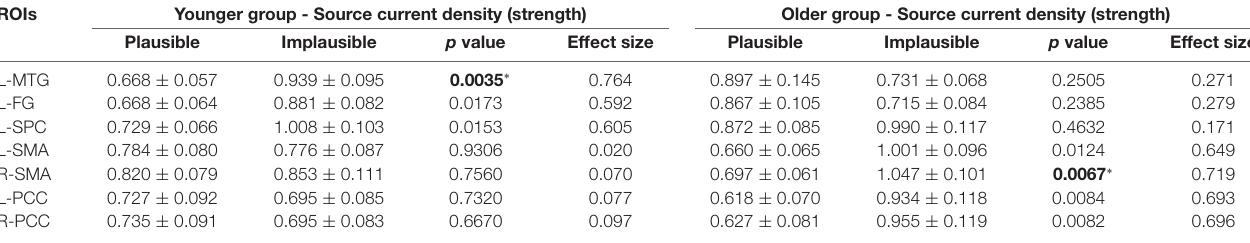
TABLE 3 | Comparison of source activity according to plausibility condition for each ROI (within each group).